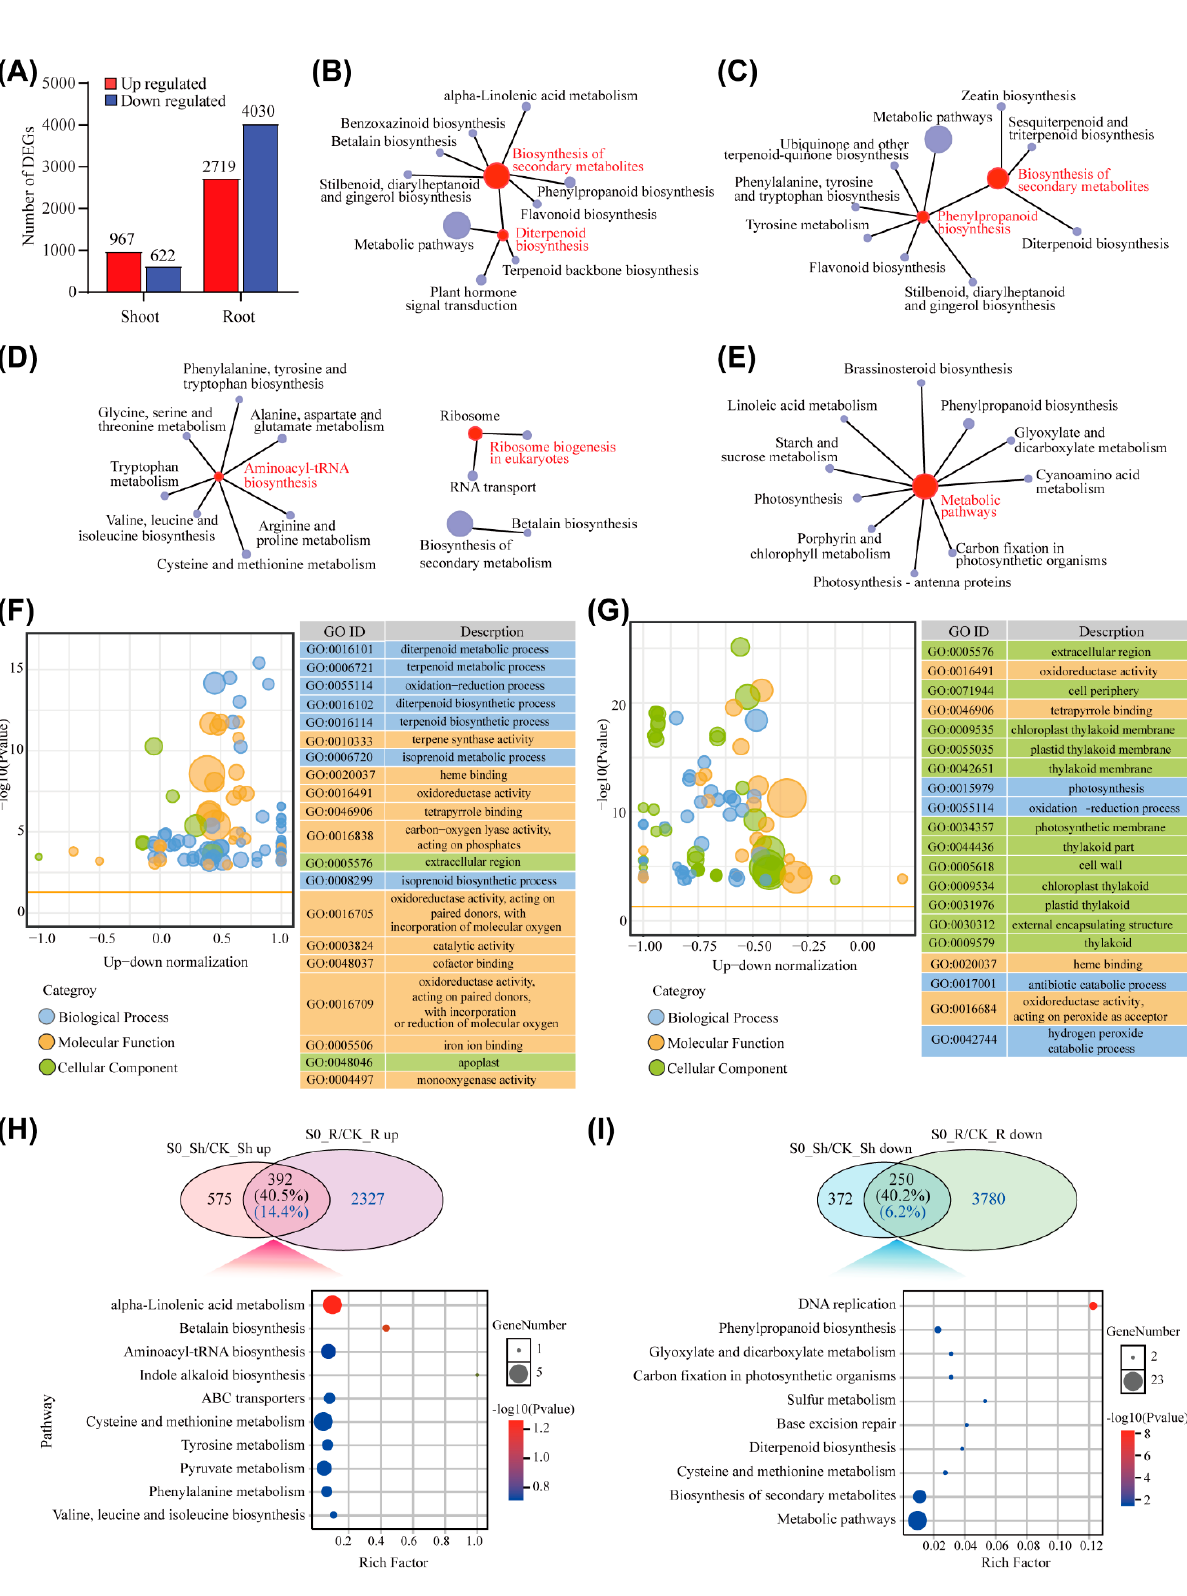
Figure 2. Transcriptomic response to S deficiency in rice. ( A ) Total numbers of DEGs in shoots and roots of plants grown under S-deficient conditions for 15 d. DEGs were identified as absolute fold change ≥ 2 with FDR < 0.05 and p < 0.05. ( B , C ) KEGG networks of up-regulated DEGs ( B ) and down-regulated DEGs ( C ) in shoots. ( D , E ) KEGG networks of up-regulated DEGs ( D ) and down-regulated DEGs ( E ) in roots. ( F , G ) Z-score bubble plot of GO enrichment analysis of DEGs in shoots ( F ) and